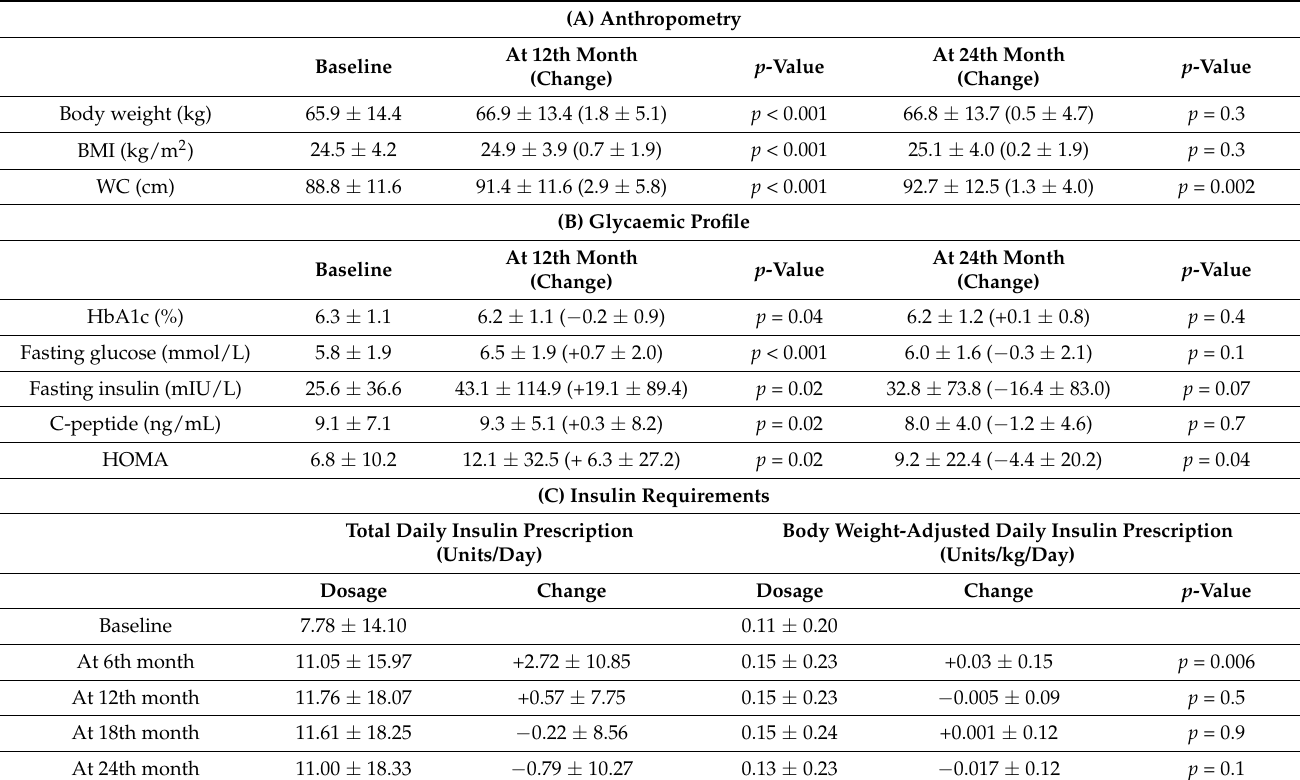
Table 3. Longitudinal change in (A) anthropometry, (B) glycaemic profile, and (C) insulin require- ments.